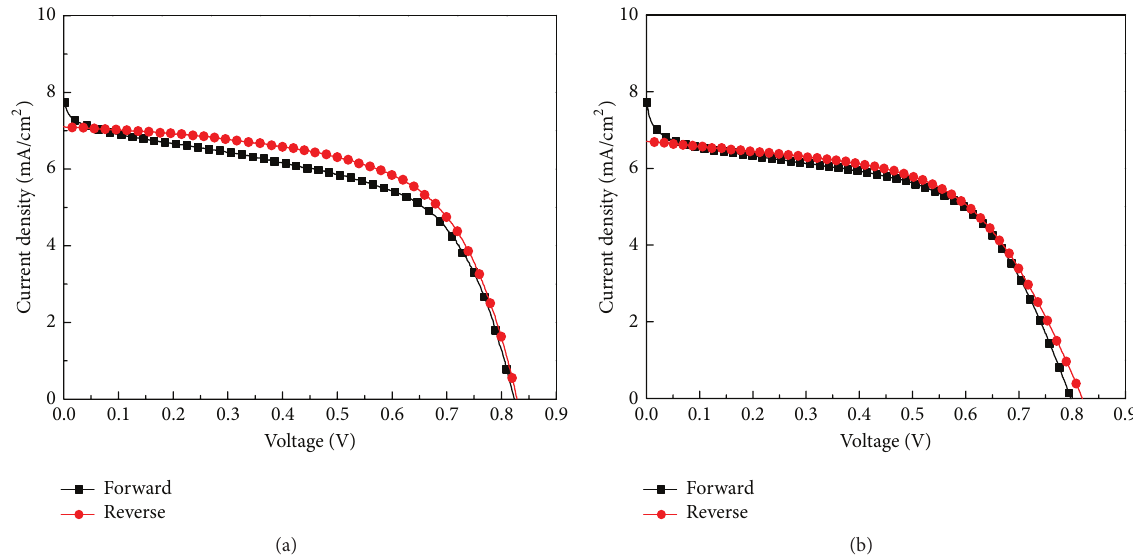
Figure 12: The typical 𝐽 - 𝑉 characteristics of forward and reverse scan of MPSCs with the drying time of (a) 0 min and (b) 10min. From short circuit to forward bias (black) and from forward bias to short circuit (red) current density-voltage curves are obtained under AM1.5